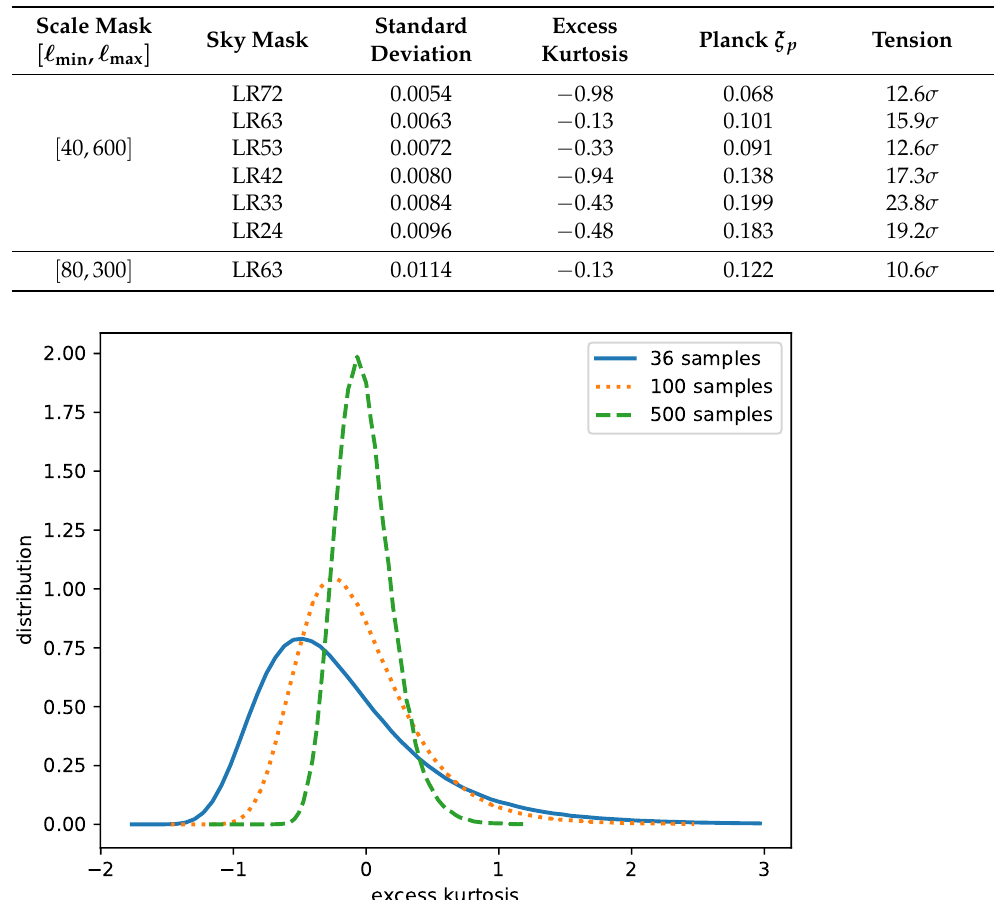
Table 1. The ξ p statistics from 36 DUSTFILAMENTS simulations. The last two columns show the Planck ξ p value and its tension with the simulations.